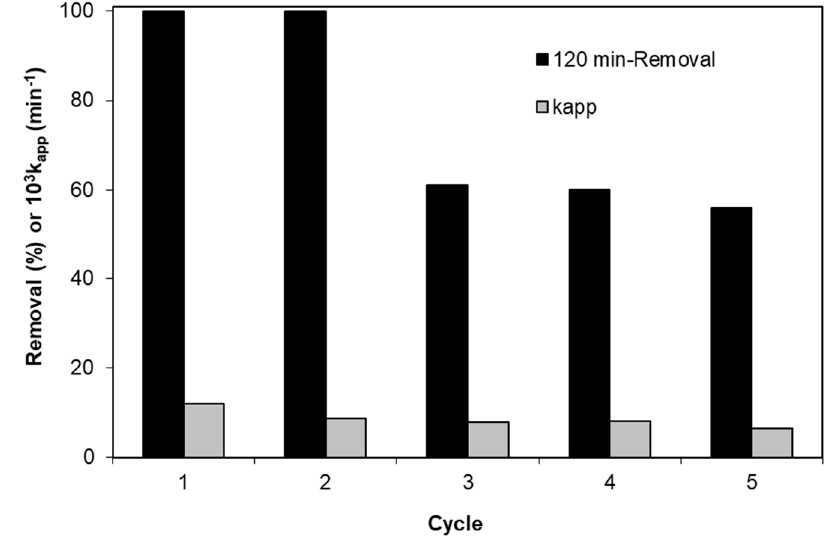
Figure 12. Catalyst reusability for SMX degradation in UPW. [SMX] = 117 µ g / L, [0.04%Fe / TiO 2 ] = 1 g / L and natural pH.